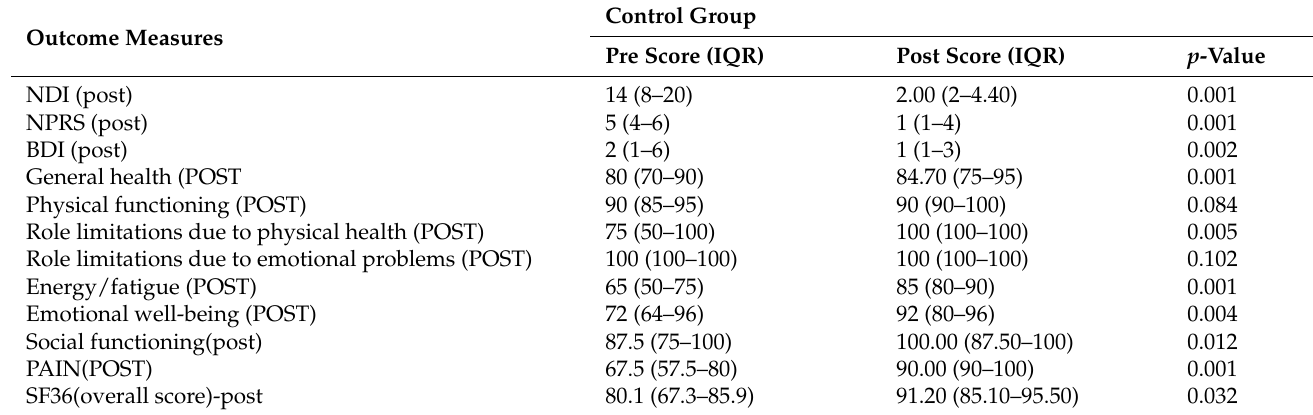
Table 4. Within groups comparison of the control